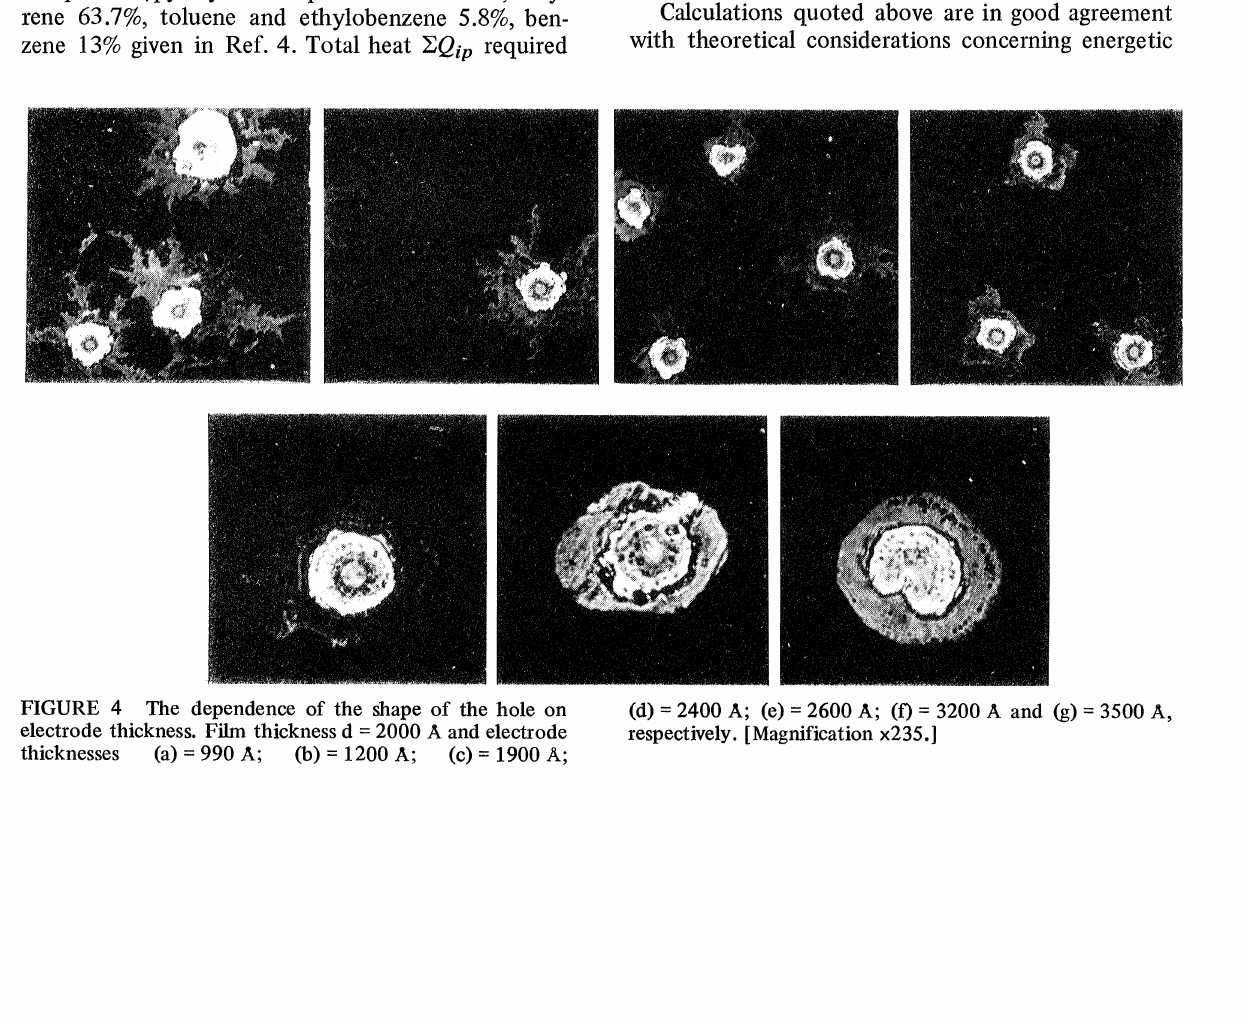
FIGURE 4 The dependence of the shape of the hole on electrode thickness. Film thickness d 2000 A and electrode